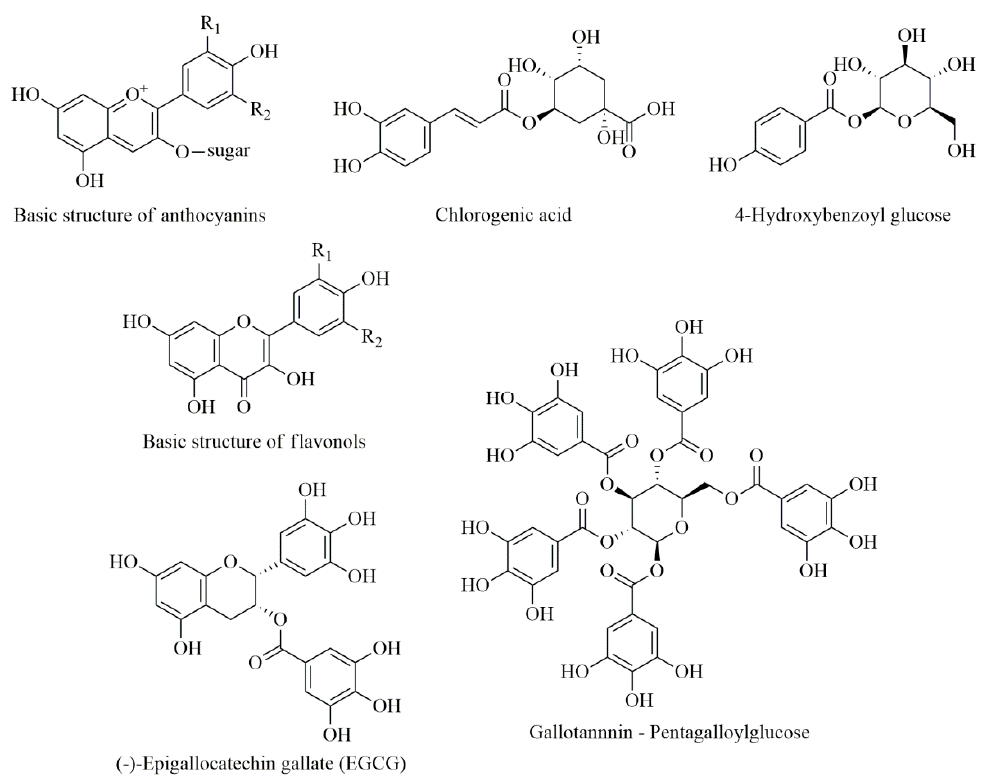
Figure 1. Chemical structures of some polyphenols commonly occurring in fruits.